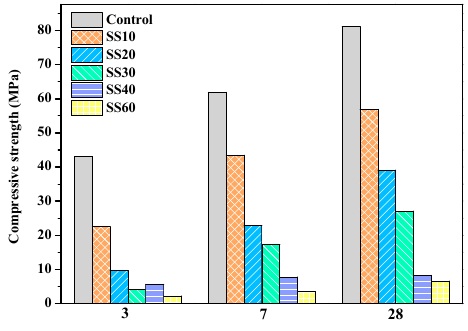
Figure 2. Compressive strengths of the control, SS10, SS20, SS30, SS40, and SS60 with air curing at 3 days, 7 days, and 28 days.